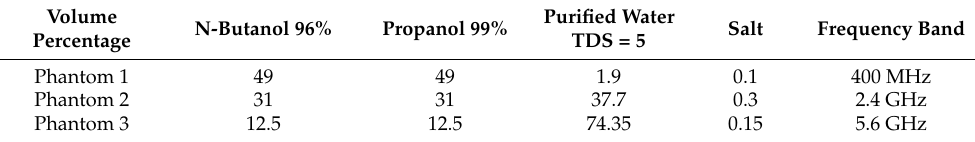
Table 3. Materials of the liquid phantoms.